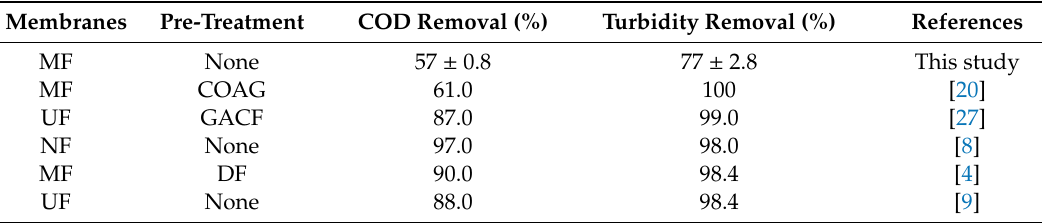
Table 2. Performance of membrane filtration in laundry wastewater